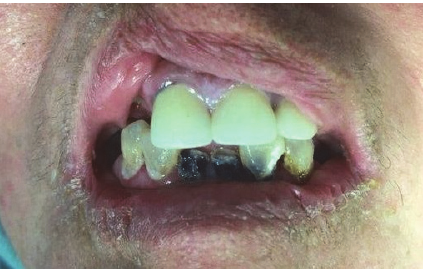
Figure 1: Preoperative airway examination showing extremely poor dental condition.